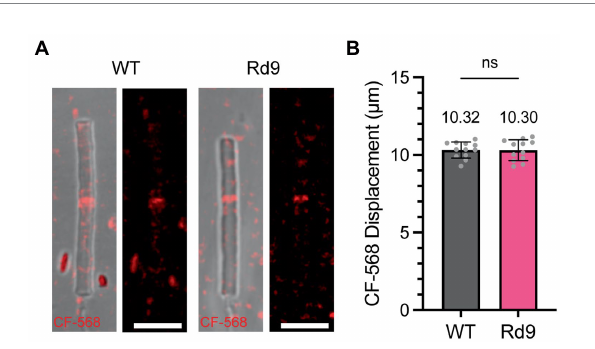
FIGURE 5 Rate of new disc addition is not affected by loss of RPGR-ORF15. (A) Images showing representative isolated outer segments from WT and Rd9 mice 5 days after CF -568 injection. Differential interference contrast (DIC) overlay on left and CF -568 alone on right. Scale bar, 5 μ m. (B) Bar graph plotting the distance between the outer segment base and the band of incorporated CF -568. Mean values are displayed above the bar. Error bars represent S.D. Unpaired Student’s two-tailed t- test: ns p = 0.9543.